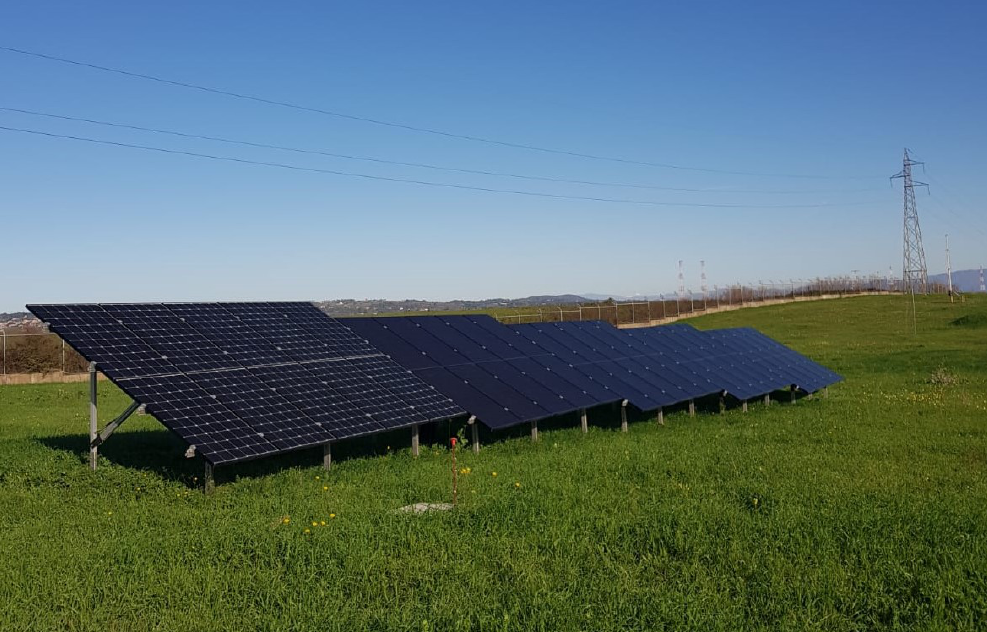
Figure 3. Photovoltaic (PV) plant located in Research Center ENEA Casaccia used to validate the